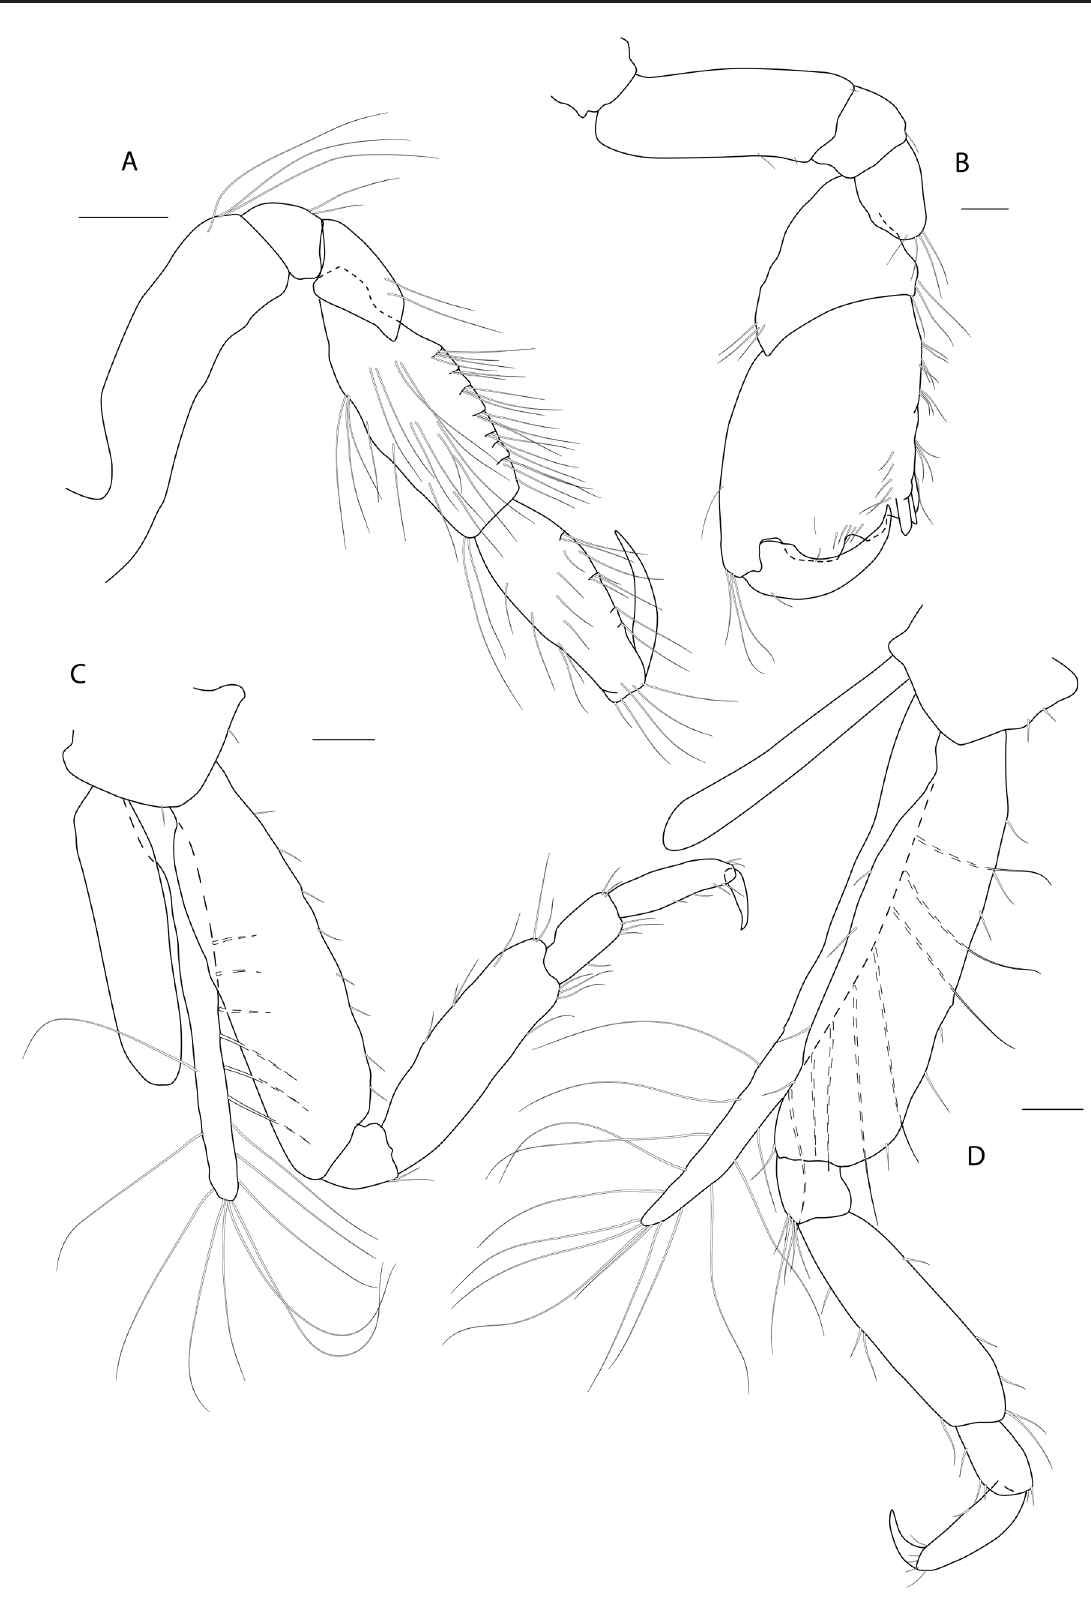
Fig. 5. Bryoconversor tutus gen. et sp. nov., holotype, ♀, NIWA 88918, 1.72 mm long. A . Gnathopod 1. B . Gnathopod 2. C . Pereopod 3. D . Pereopod 4. Scale bars = 100 μ